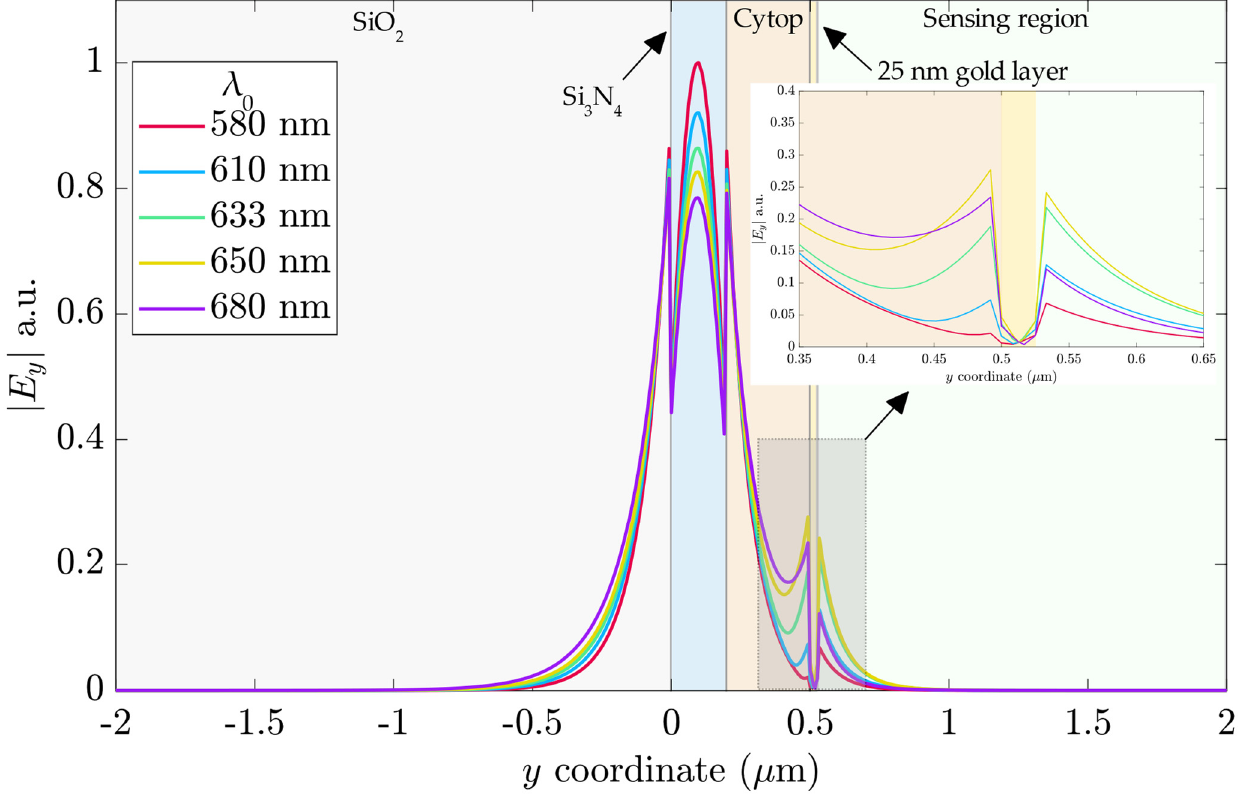
Figure 10. The electric field profile of the y-component at x = 0 μ m. Inset: closeup of the gold layer region.